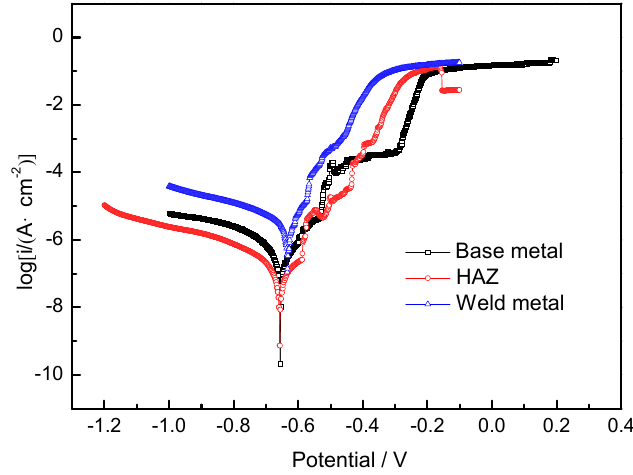
Figure 7. Corrosion potentials of the base metal, heat-affected zone and weld metal in 3.5% NaCl solution.